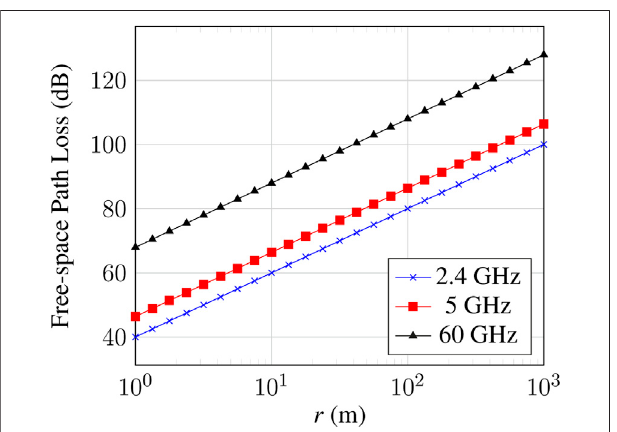
FIGURE 1 | Antenna arrangement in a free space radio system.